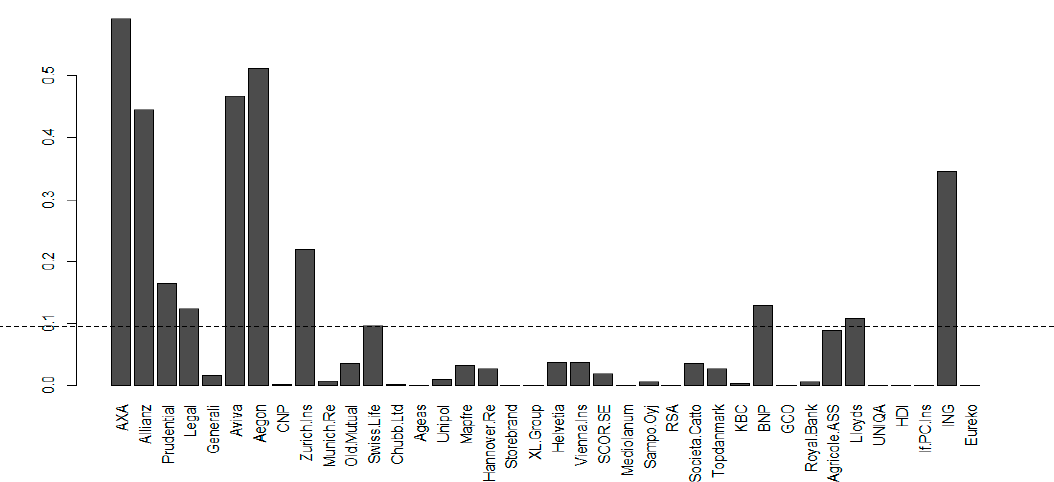
Figure 2. Average value of betweenness centrality (BC) in the period under consideration for individual insurance institutions. Source: Own study.